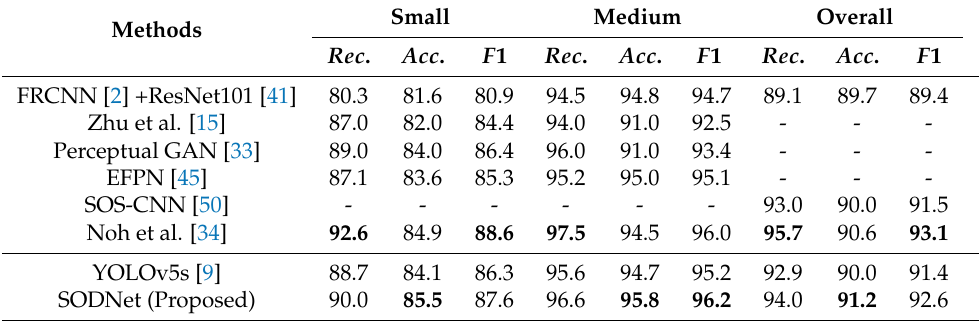
Table 4. Performance comparison with the state-of-the-art models on the Tsinghua–Tencent 100K test dataset. Partial experimental data shown in this table are missing, because some models [15,33,45,50] only provide a part of the related data. The best results are marked in bold.